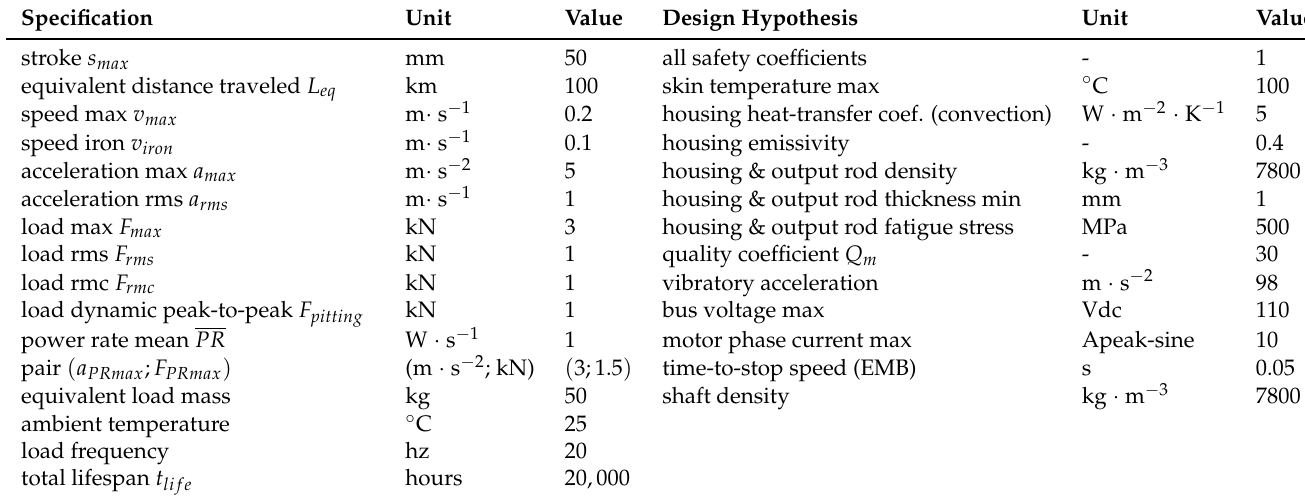
Table 5. Arbitrary specification and its design